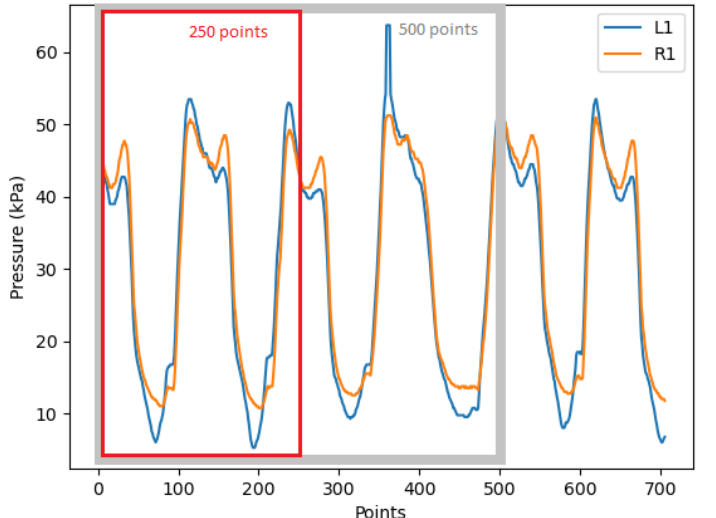
Figure 7. A sensor data frame in lengths of 250 and 500 points. ( L 1 is the first sensor in dataset L , and R 1 is the first sensor in dataset R